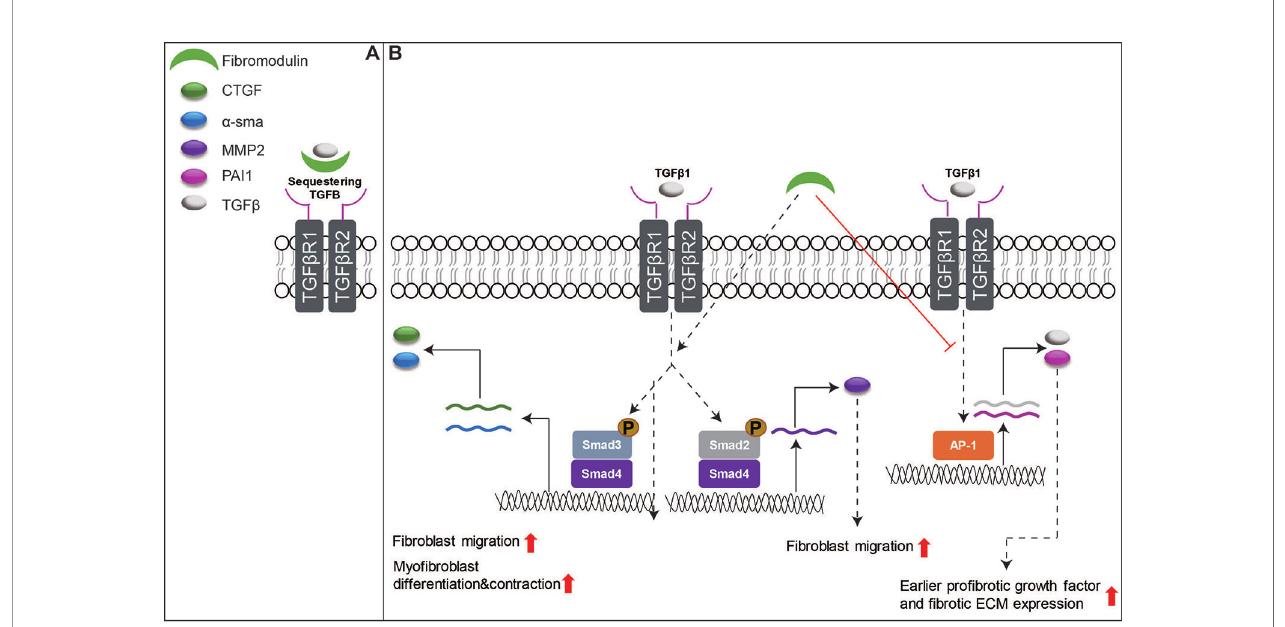
FIGURE 4 | Schematic depiction of the functions of FMOD in skin wound healing. (A) FMOD is able to bind to all three mammal TGF b isoforms as an extracellular TGF b reservoir. (B) Importantly, FMOD can selectively enhance SMAD3-mediated TGF b 1-responsive pro-migration and pro-contraction signaling, while reducing AP-